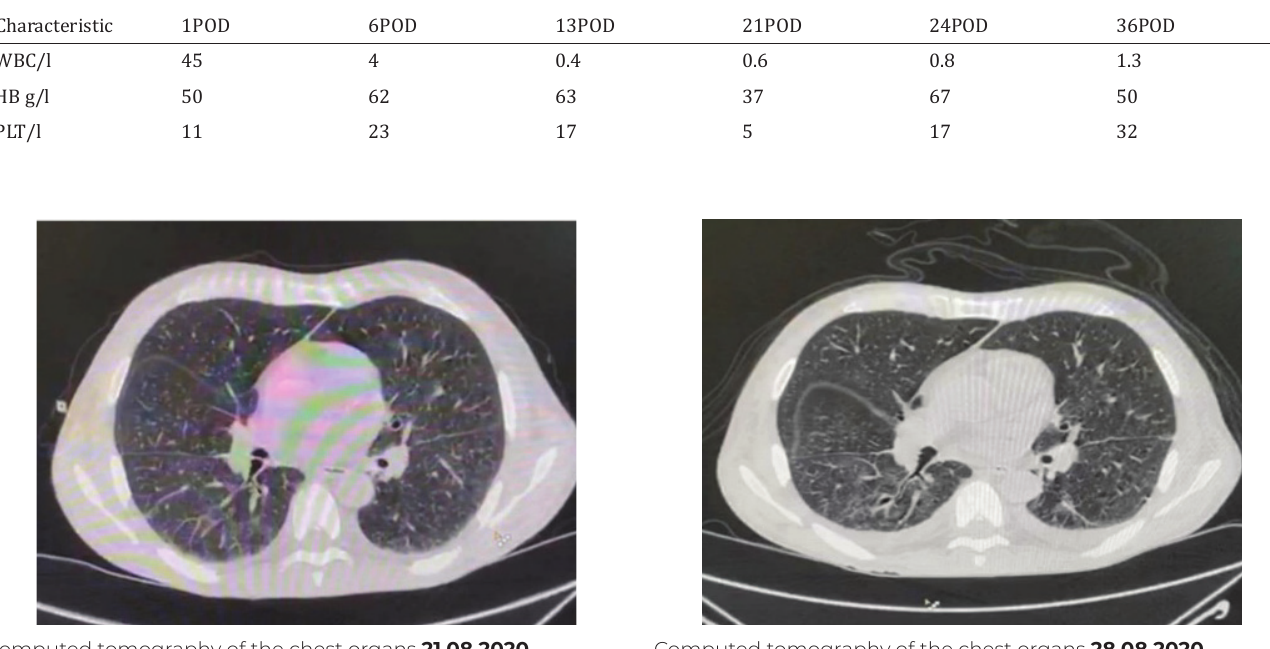
Table 2 Changes in peripheral blood parameters by day from the start of therapy. Against the background of the complex therapy of hemoblastosis and COVID-19, a decrease in leukocytosis is noted, up to agranulocytosis, followed by an increase in leukocyte counts.